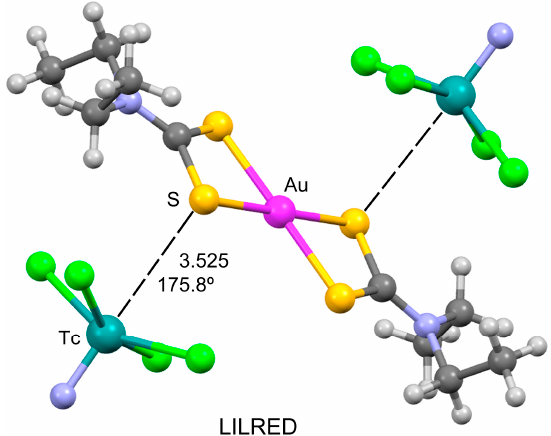
Figure 5. Ball and stick representation of the X-ray structure LILRED. Distance in Å. Color code: Carbon grey, Chlorine green, Nitrogen blue, Technetium teal, Gold pink, Sulfur yellow, Hydrogen light grey.